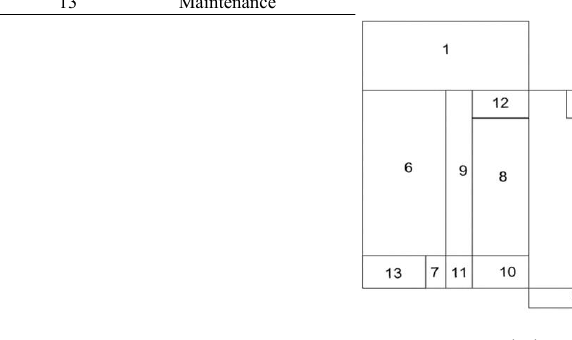
Fig. 1. Existing plant layout